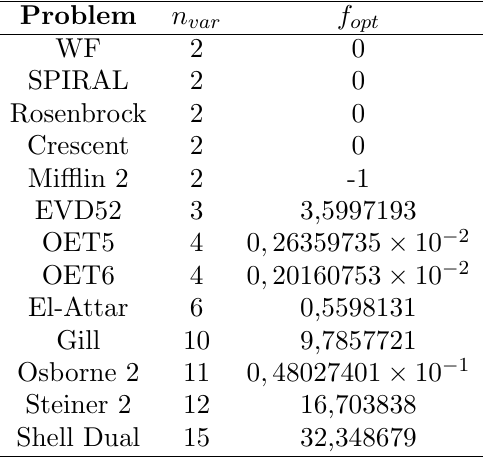
Table 2. List of Non-Convex